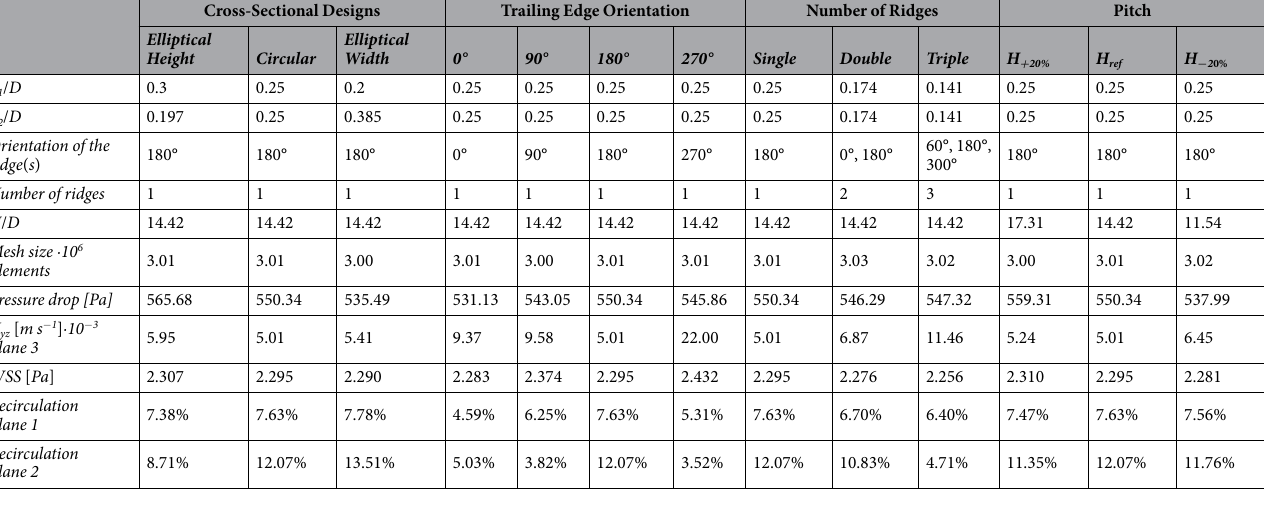
Table 1. Features of different configurations of ridge design and quantitative results in terms of pressure drop in the fluid domain, area-weighted average secondary velocity, spatial mean of wall shear stress in the host artery and percentage of cross-sectional area affected by